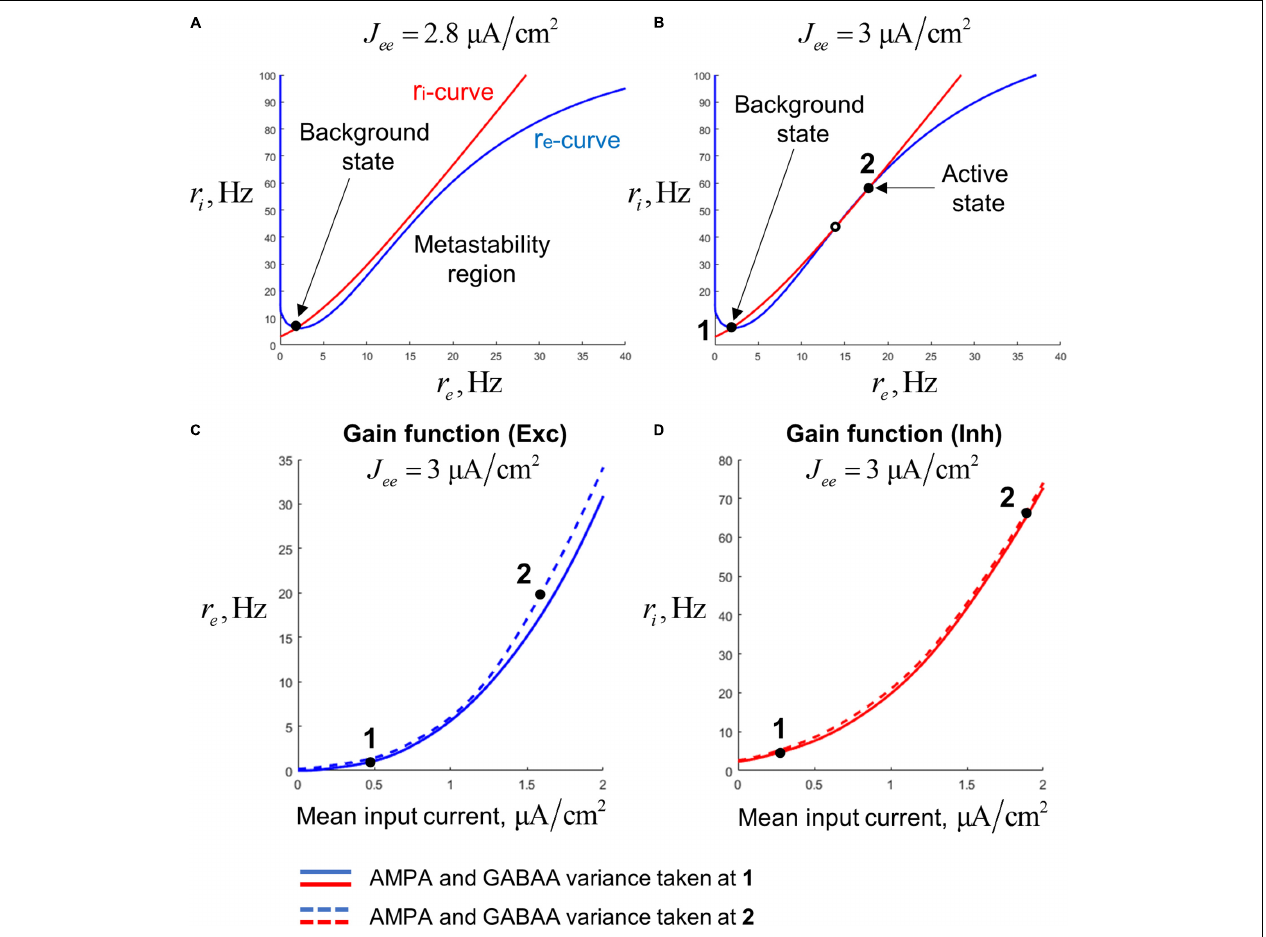
FIGURE 2 | Steady states of a single-circuit model. (A) Phase plane for the single-circuit model analyzed in our study. For the points on the blue curve (re-curve), all the derivatives, except of dri/dt are zero; for the point on the red curve (ri-curve), all the derivatives, except of dre/dt are zero. The system has the single (background) steady state and the region of slowly decaying activity (metastability region), where the re- and ri-curves are close to each other. (B) Phase plane for a system with increased recurrent excitation. The system has the background steady state (denoted as 1) and the active steady state (denoted as 2). (C) Two slices of the gain function of the excitatory population, representing dependence of the excitatory firing rate on the mean input current to the excitatory population. Solid curve – the slice taken at the constant values of the AMPA- and GABAA-current variance, equal to the values calculated at the steady state 1. Dashed curve – the slice taken at the variance values calculated at the steady state 2. (D) Same as (C) , but for the inhibitory